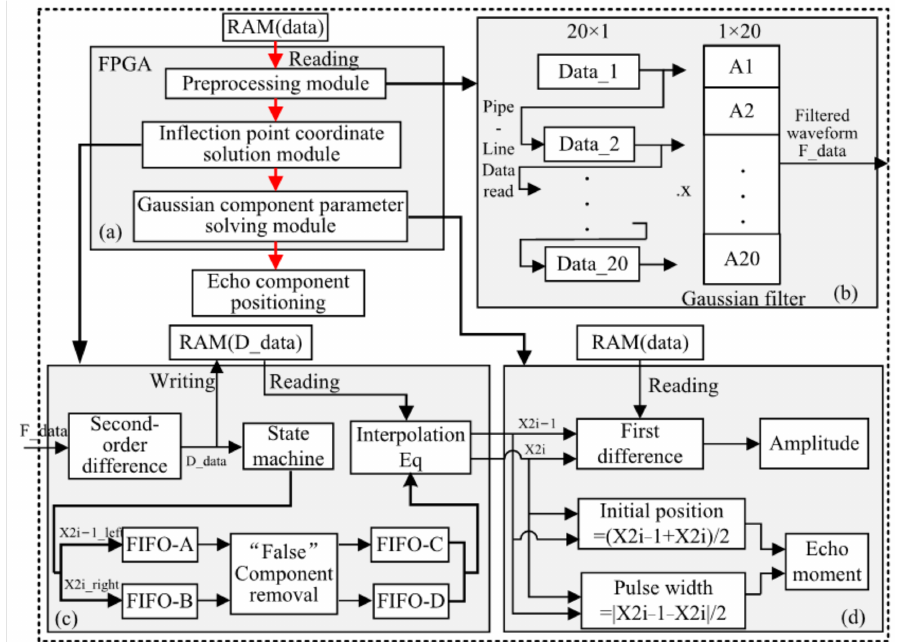
Figure 5. FPGA architecture: ( a ) overall architecture; ( b ) pre-processing architecture; ( c ) inflec- tion point coordinate solution architecture; ( d ) Gaussian component parameter solution and echo component positioning